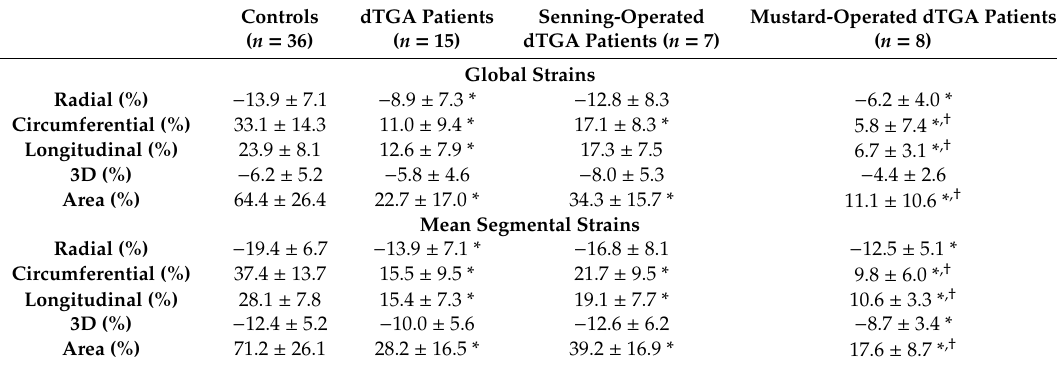
Table 3. Comparison of three-dimensional speckle-tracking echocardiography-derived peak global and mean segmental left atrial strains of patients with dextro-transposition of the great arteries and those of